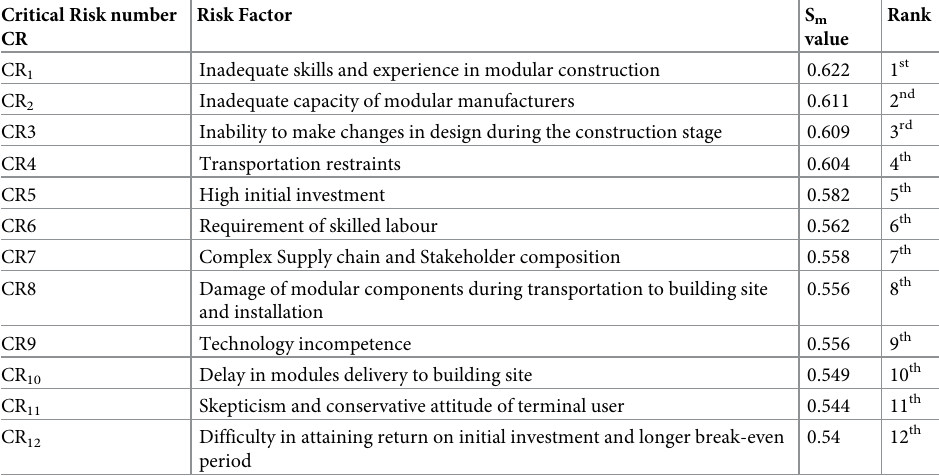
Table 5. Rank of critical risks based on group decision